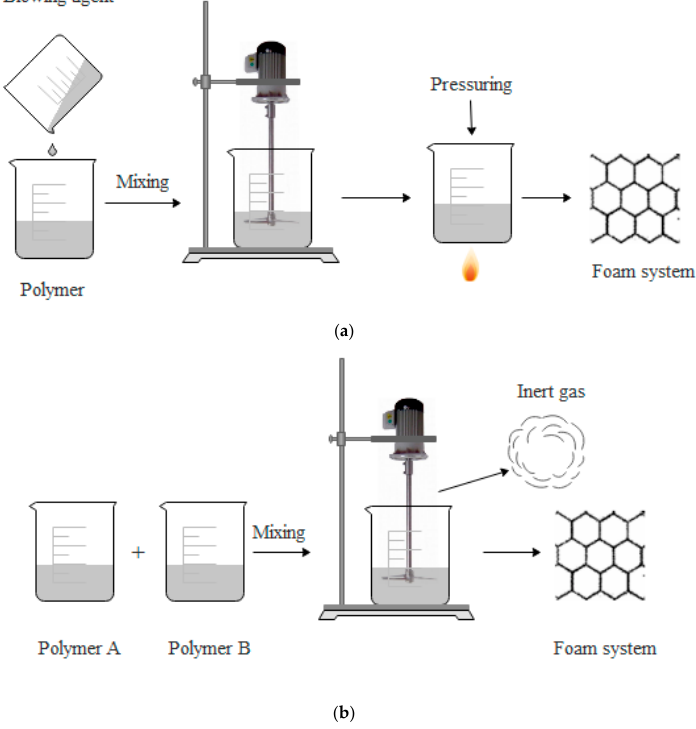
Figure 4. Schematic diagram of chemical foaming .